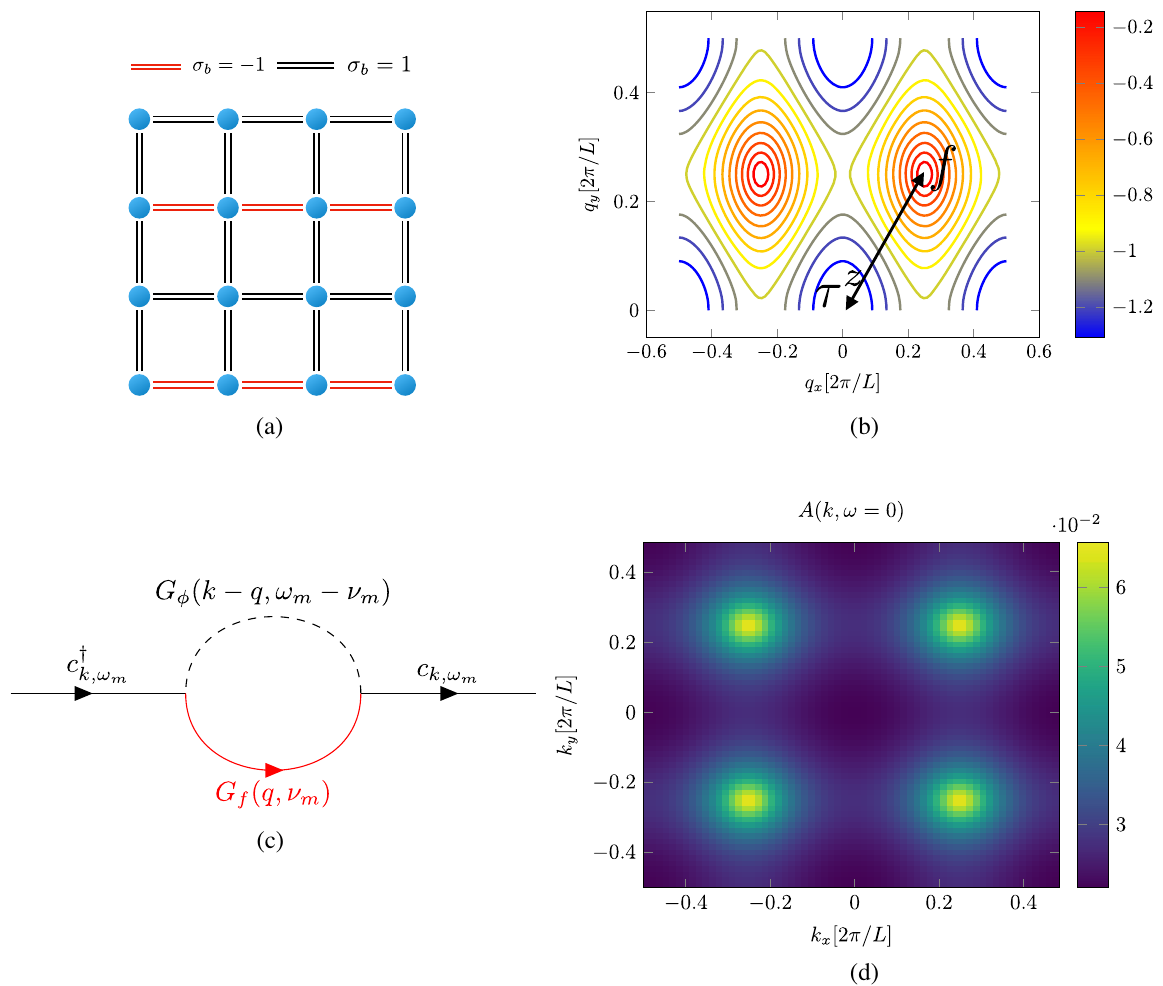
FIG. 6. (a) Ising Landau gauge-fixing condition for the π -flux lattice; black (red) bonds correspond to σ z ¼ 1 ( − 1 ). (b) Energy b contours of the lower-band Dirac spectrum on the π -flux lattice using the above gauge fixing. (c) Leading-order Feynman diagram for the physical fermion c propagator G β c ð k; i ω . The bubble diagram evaluates to a convolution between the Ising matter field ϕ z and m Þ orthogonal fermion f σ propagators defined on the π -flux lattice. (d) Finite-temperature spectral function A ð k; ω ¼ 0 Þ computed by a numerical evaluation of the bubble